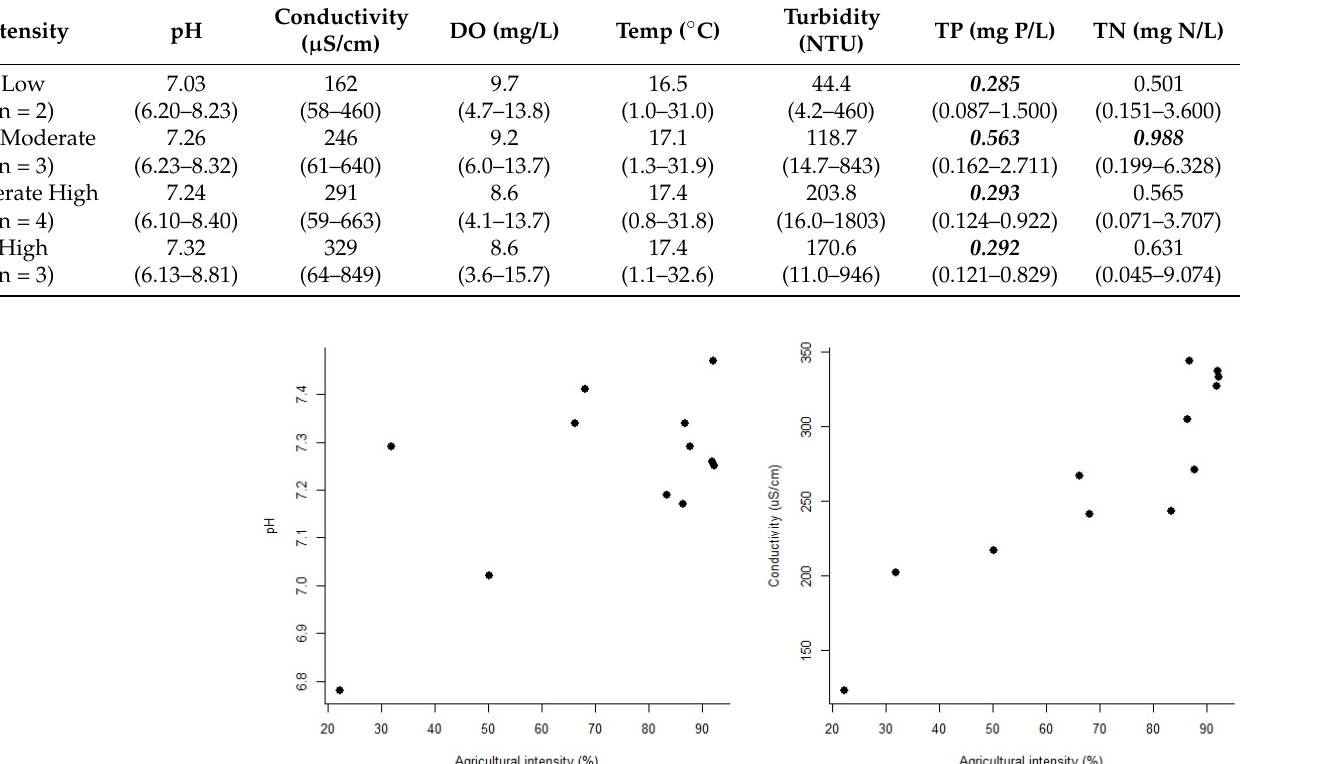
Figure 2. Relationship between physicochemical parameters and agricultural intensity in the Cache River Watershed, Arkansas, sampled weekly from October 2017 to September 2020. Similarly, mean turbidity increased from low to high intensity; however, the moder- ate high intensity had the greatest mean nephelometric turbidity unit (NTU). Mean and median NTUs for all agricultural intensities were below the 250 NTU criteria set for “chan- nel altered Delta” streams by the Arkansas Pollution Control and Ecology Commission (APCEC); however, significant differences existed among sites ( χ 2 = 346.8, df = 3, p < 0.001) [33]. No statistical similarities existed among agricultural intensities, as all were signifi- cantly different from one another ( p ≤ 0.02; Figure 3). Turbidity and agricultural intensity were not significantly correlated with one another (rs = 0.522, p = 0.082). Throughout the 3-year sampling period, the 250 NTU criteria set by the APCEC was exceeded >20% of the time in moderate high- and high-intensity areas, below the 25% criteria.